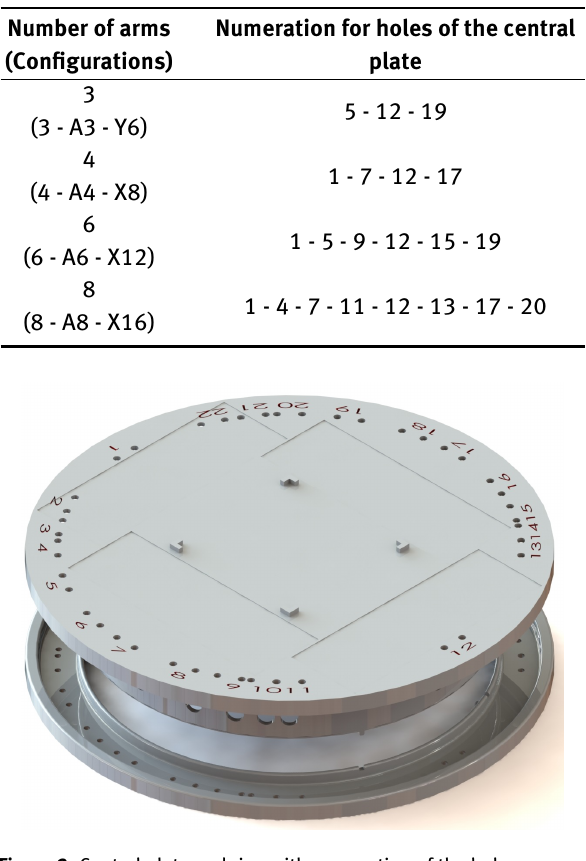
Figure 2: Central plate and ring with numeration of the holes.